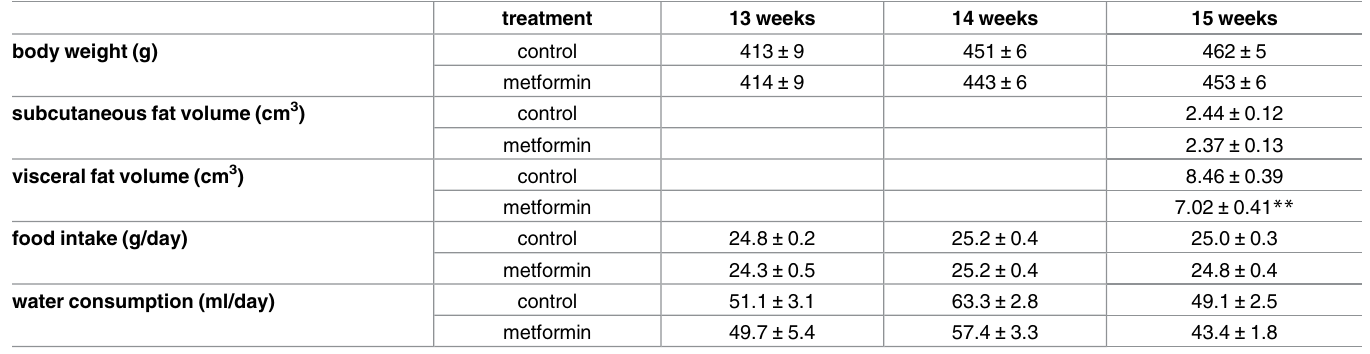
Data are presented as mean ± S.E. n = 12 in each